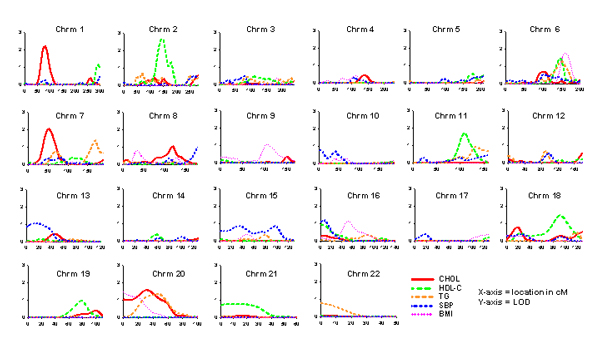
Genome-wide LOD scores for CHOL (red), HDL-C (green), SBP (blue), TG (orange), and BMI (pink).